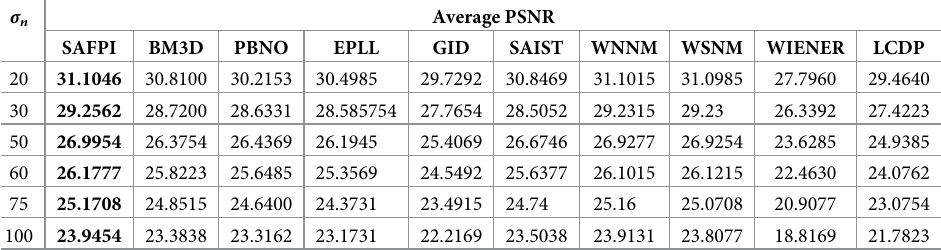
Table 7. Comparison of average PNSR with different methods.